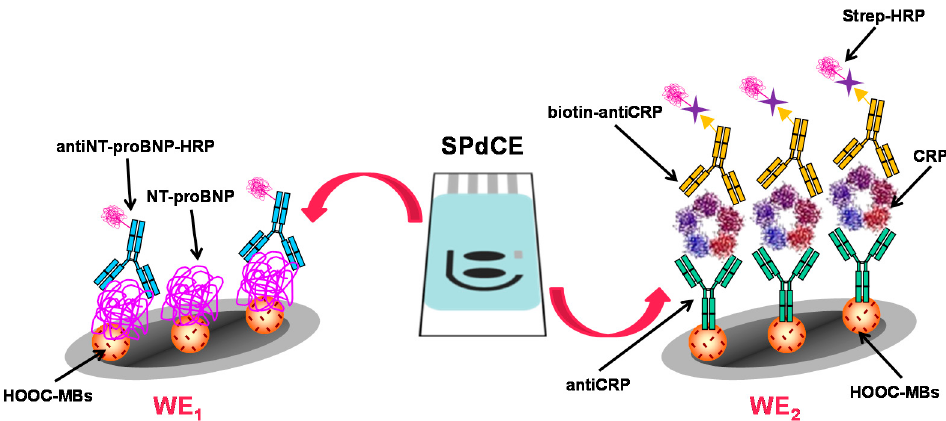
Figure 3. Schematic display of the disposable dual magnetoimmunosensor prepared for the determination of NT-proBNP and CRP. Reprinted from Ref. [26] with permission.